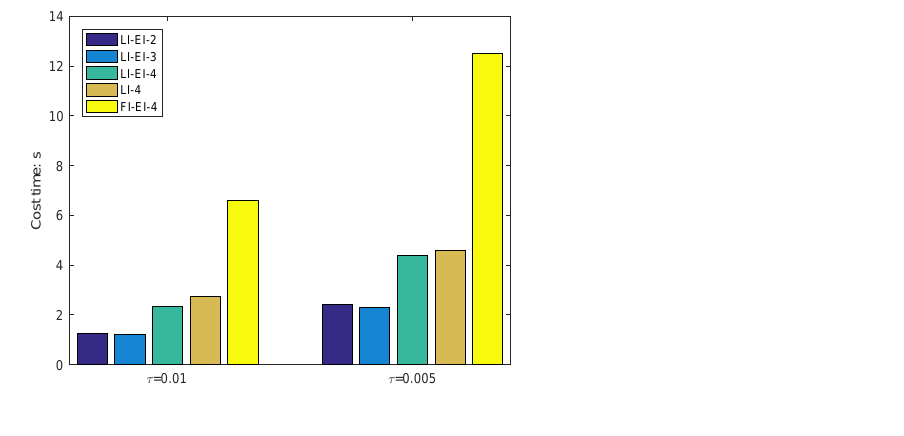
Figure 1. CPU time with different time steps till T = 50.